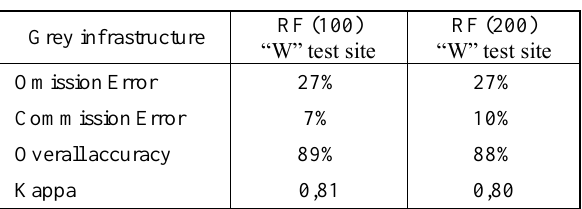
Table 5. Random Forests classification of grey infrastructure accuracies for “W” test